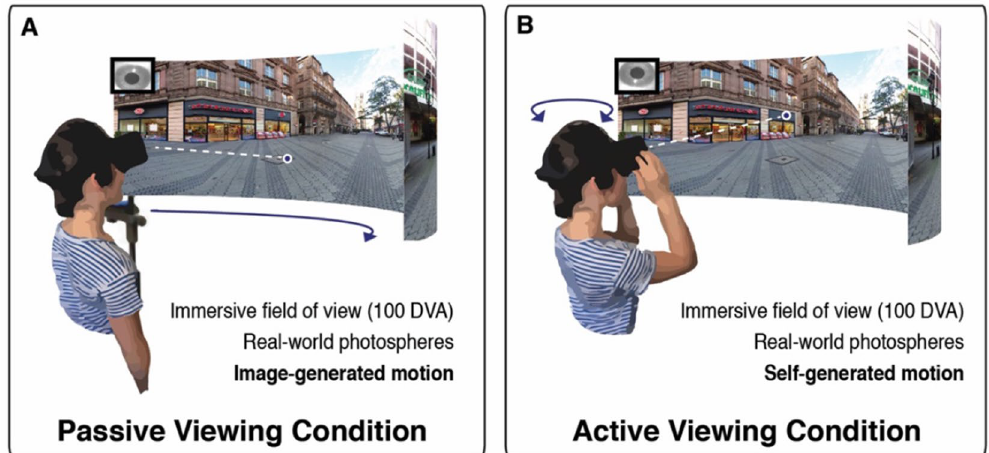
Figure 1. Passive viewing condition vs. active viewing condition. On each trial, participants viewed immersive, 360° real-world scenes via a headmounted VR display while gaze position was monitored using an in-headset eye-tracker. ( A ) In the passive condition, participants were head-restricted using a chin rest, and scenes panned across the display. ( B ) In the active condition, participants explored scenes from a first-person perspective through movement of their eyes, head, and